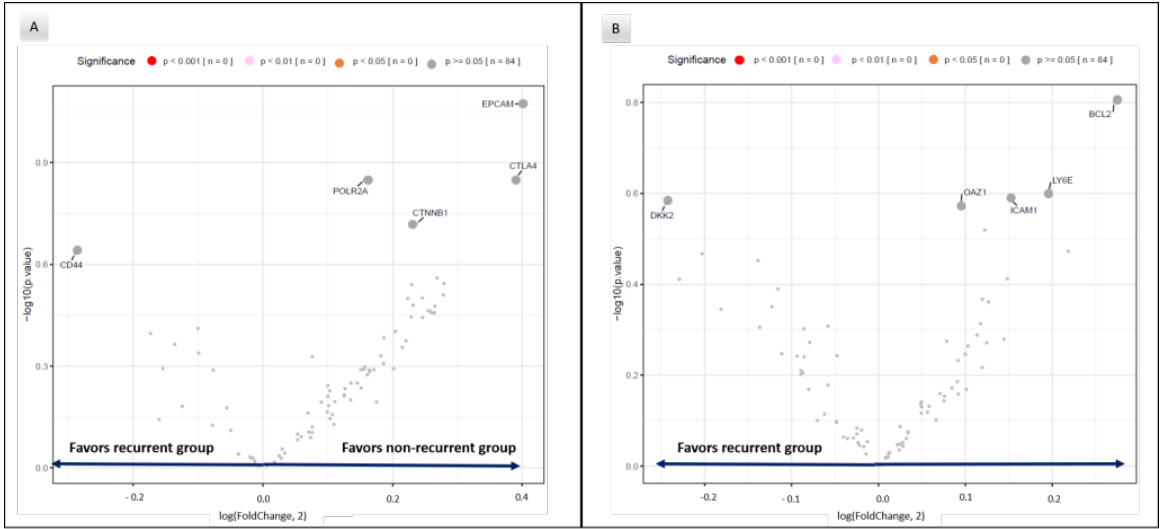
Figure 3. Volcano plots of RNA biomarkers for tumor ( A ) and tumor microenvironment ( B ) compartments in recurrent vs. non-recurrent samples.